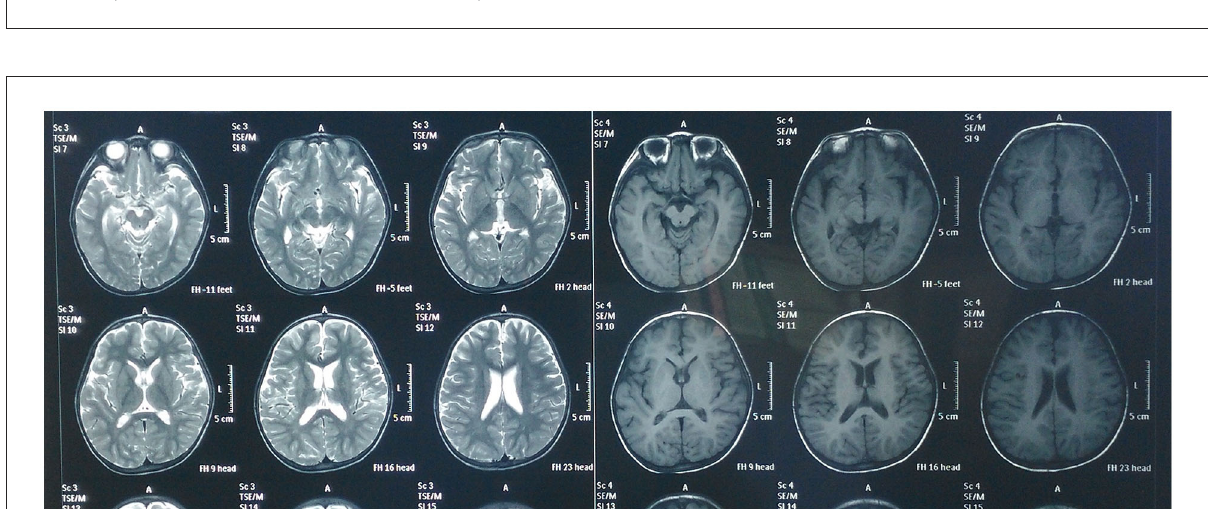
FIGURE4 Magnetic resonance imaging of the brain after receiving Tongdu Xingshen acupuncture suggested mild brain atrophy and pachymeningeal enhancement associated to meningitis